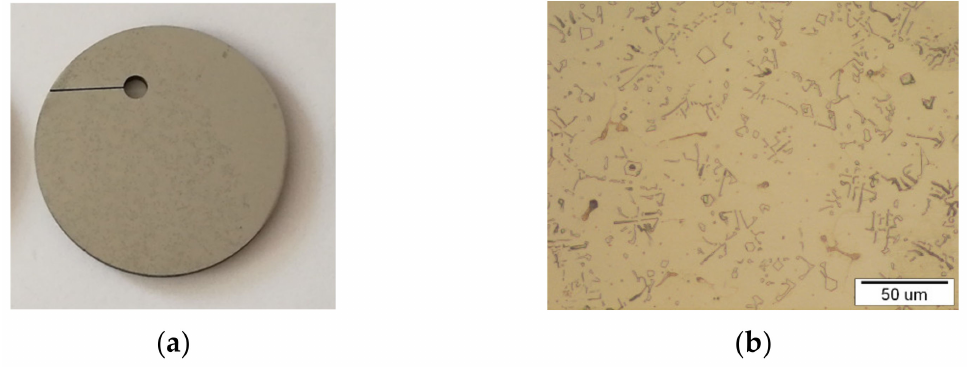
Figure 1. NiTi disc: ( a ) presentation of a macro view and ( b ) representative optical